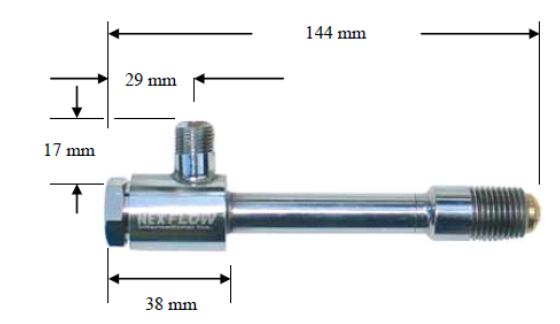
Figure 1. Photograph of the Vortex tube with